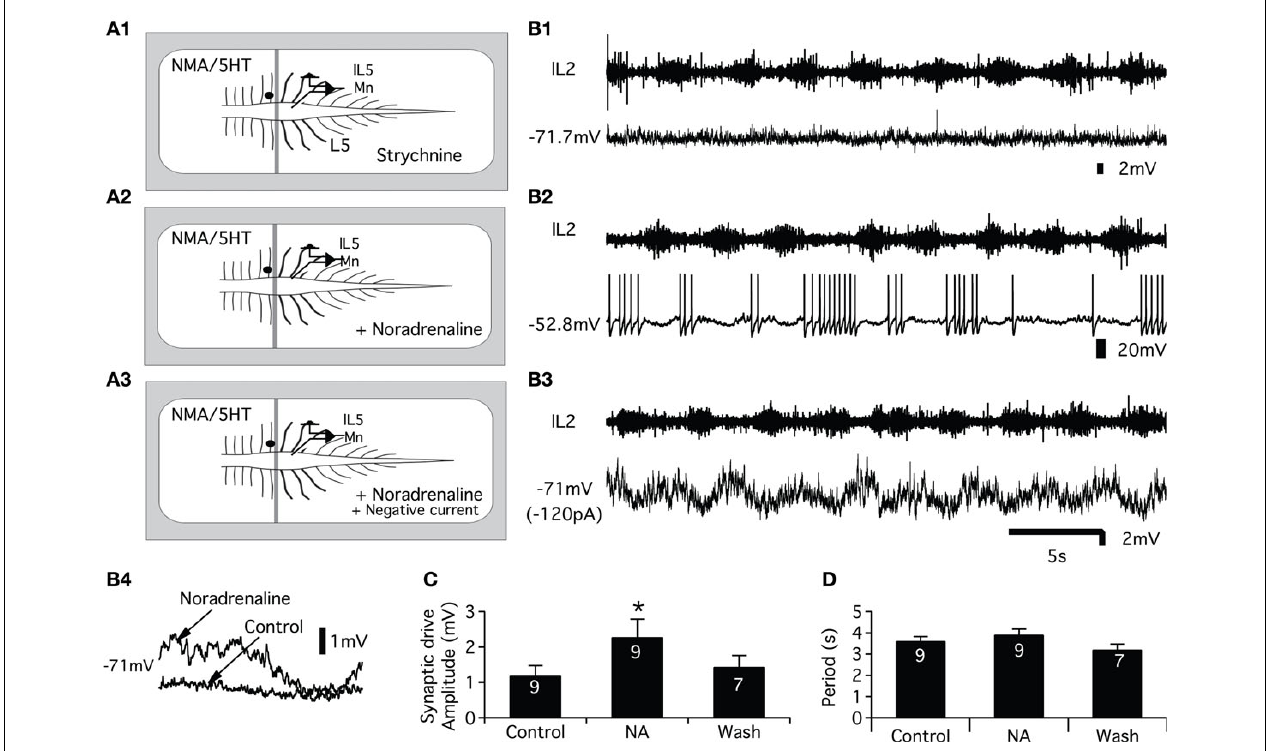
FIGURE 6 | Effects of NA on the glutamatergic synaptic drive. (A) Schema of the experimental procedure. Vaseline wall (grey bar) was built at the L2 level. NMA/5HT was bath applied to the rostral compartment whereas strychnine alone (A1) or in combination with noradrenaline (NA) (A2,A3) was superfused onto the caudal compartment. ( B) Representative traces recorded from a left L5 motoneuron (lL5) that was rhythmically depolarized out of phase with the lL2 ventral root activity (B1) . In the